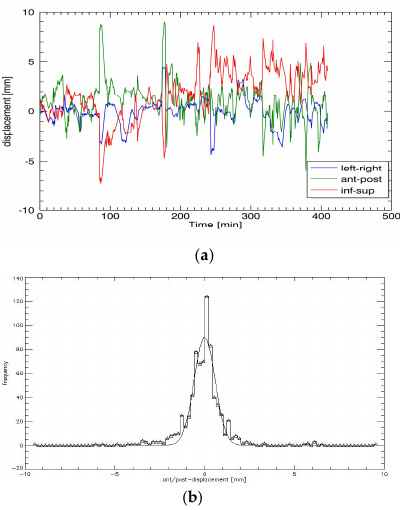
Figure 1. CTV prostate displacement pattern of one patient in all directions, x , y , and z ( a ), and distribution of the CTV prostate in one patient in anterior/posterior direction using a time interval of I = 50 s ( b